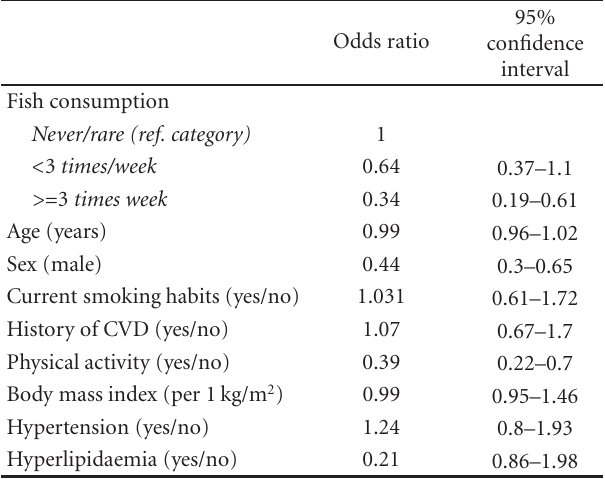
Table 4: Logistic regression analysis of fish consumption on depression status (GDS >